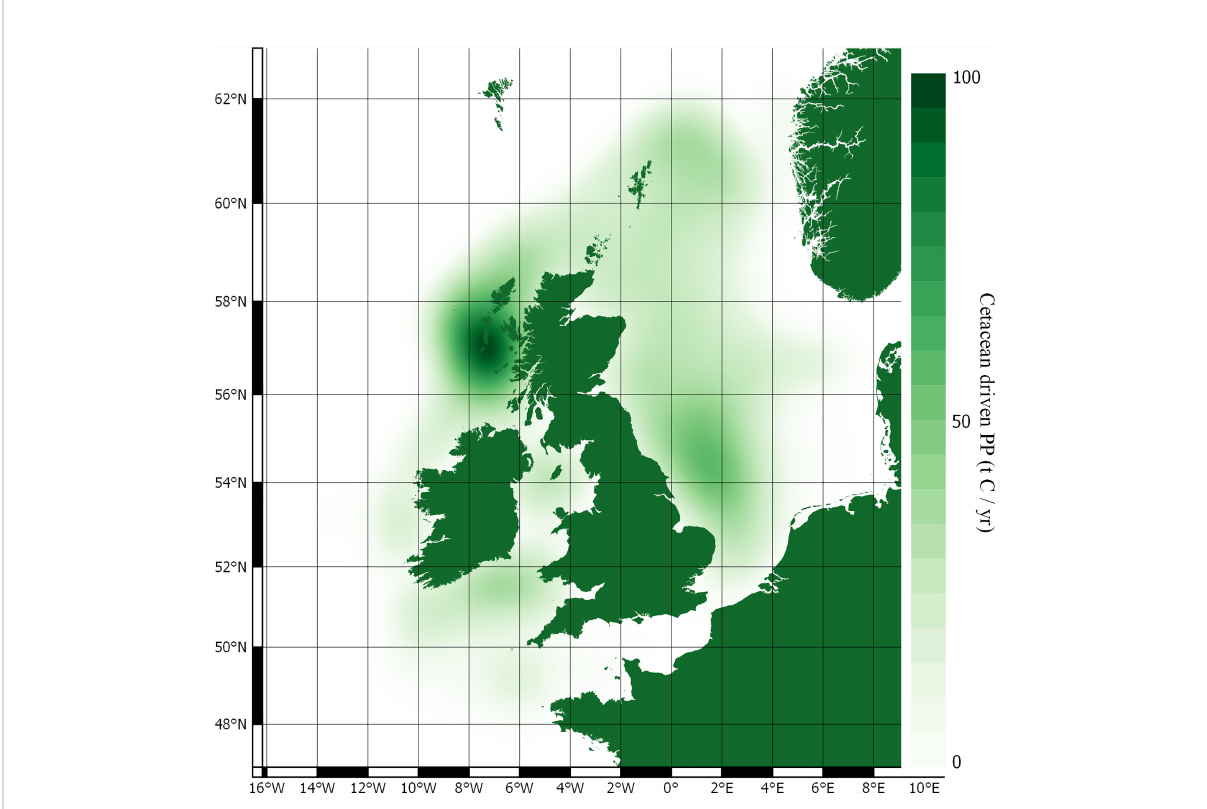
FIGURE 4 Cetacean driven PP carbon fl